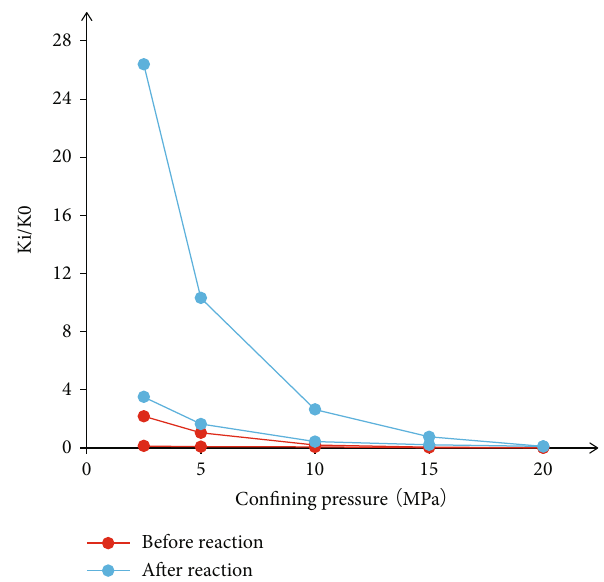
Figure 5: Stress sensitivity of shale before and after interaction with 5000mg/L KCl solution for 48 h.